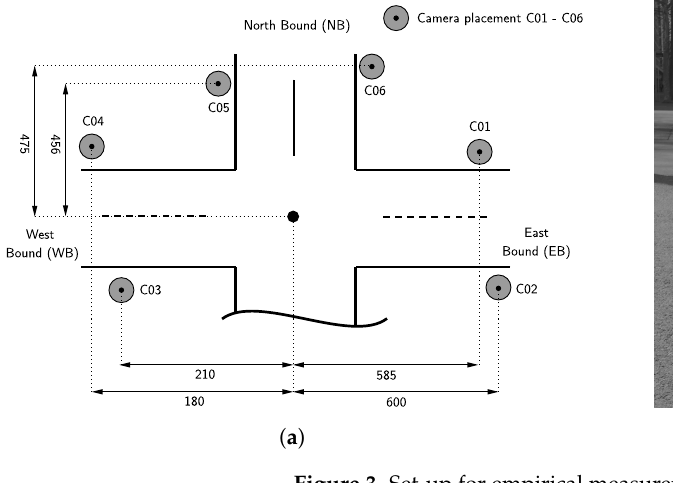
Figure 3. Set-up for empirical measurements: ( a ) placement and distance from the intersection center (in meters) of six cameras capturing traversing traffic (C01–C06), ( b ) used camera set-up with HD camera and